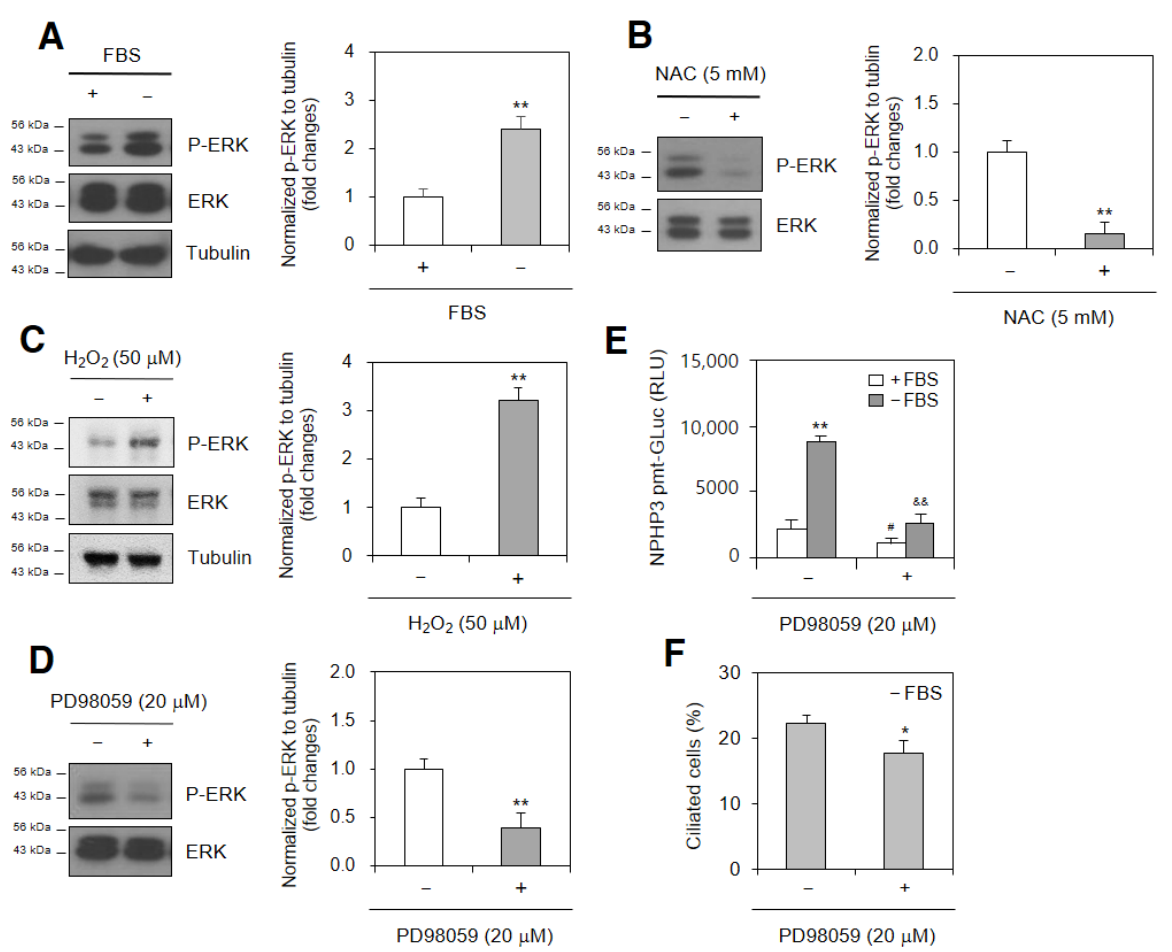
Figure 5. ERK activation under SD condition control primary cilium formation and NPHP3 expres- sion. ( A – D ) Cells were incubated with or without 5% FBS in the absence ( A , B ) or presence ( B ) of N-acetylcysteine (NAC). Cells were treated with 50 µ M H 2 O 2 for 3 h ( C ). Cells were incubated under serum-deprived (SD) condition in the absence or presence of PD98059, ERK inhibitor ( D ). Cell lysates were prepared and ERK and phospho (p)-ERK proteins were detected by Western blot analysis ( A – D left). Density of each band was analyzed by ImageJ 1.34n and results were normalized to tubulin. Relative fold changes in each band to control were represented in bar graphs ( A – D right). ( E ) Cells were transfected with pEZX-PG02-NPHP3-promoter-Gluc plasmids and incubated with or without 5% FBS in the absence or presence of PD98059 for 24 h. The activity of Gluc in cultured media was measured with luminometer using Gluc substrate. ( F ) Cells were incubated under SD condition in the absence or presence of PD98059. The cells were fixed and stained with antibody against Ac-tubulin. The primary cilium was observed with 1000 × magnification under fluorescence microscope. The ciliated cells ( n > 500 cells) were counted in each group. Data were the representative of four experiments. Processing (such as changing brightness and contrast) is applied equally to controls across the entire image ( A – D left). Data in bar graphs represents the means ± SD ( A – D right, E , F ). * p < 0.05, ** p < 0.01; significantly different from 5% FBS-treated group ( A , B , E ) or H 2 O 2 -untreated ( C ) or PD98059-untreated control ( D , F ). # p < 0.01; significantly different from PD98059-untreated group with FBS. && p < 0.01; significantly different from PD98059-untreated group without FBS ( E ).